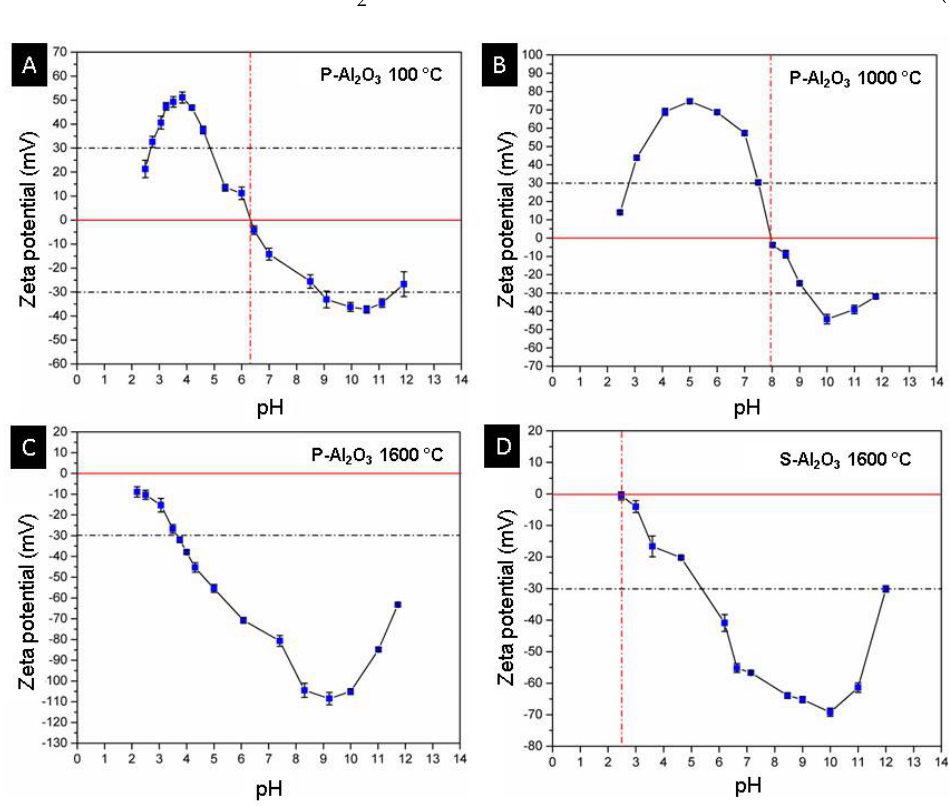
Figure 14. Curves of pH vs. zeta potential of powders and alumina sphere. ( A ) P-Al 2 O 3 at 100 °C, ( B ) P-Al 2 O 3 at 1000 °C, ( C ) P-Al 2 O 3 1600 °C and ( D ) S-Al 2 O 3 at 1600 °C